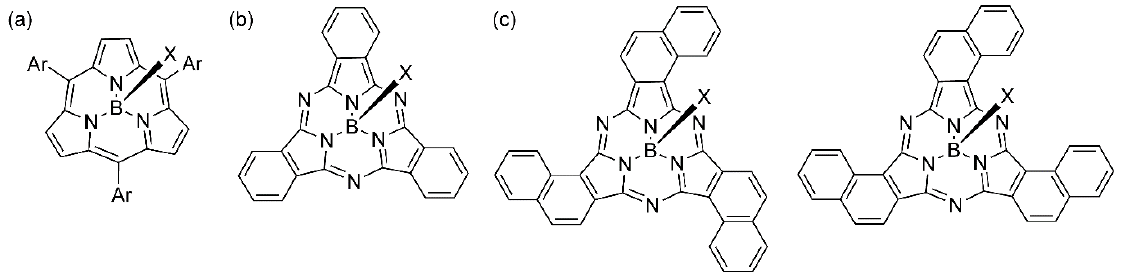
Figure 1. Structures of ( a ) meso -aryl-substituted subporphyrin, ( b ) subphthalocyanine, and ( c ) inherently chiral 1,2-subnaphthalocyanines (left: C 3 symmetric isomer; right: C 1 symmetric isomer).